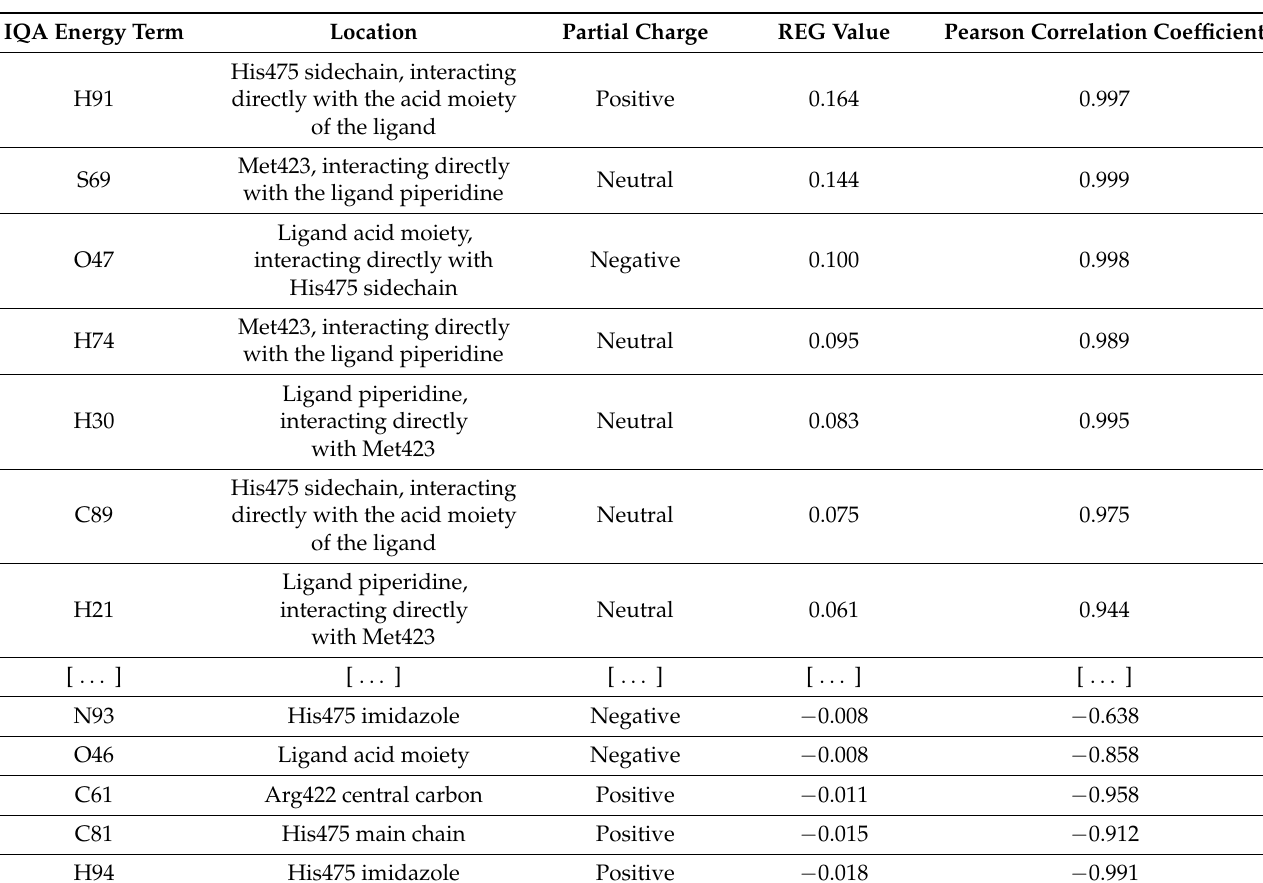
Table 2. Top (most positive) and bottom (most negative) full atomic contributions ( A-A (cid:48) ranking) by REG value for segment 1 in